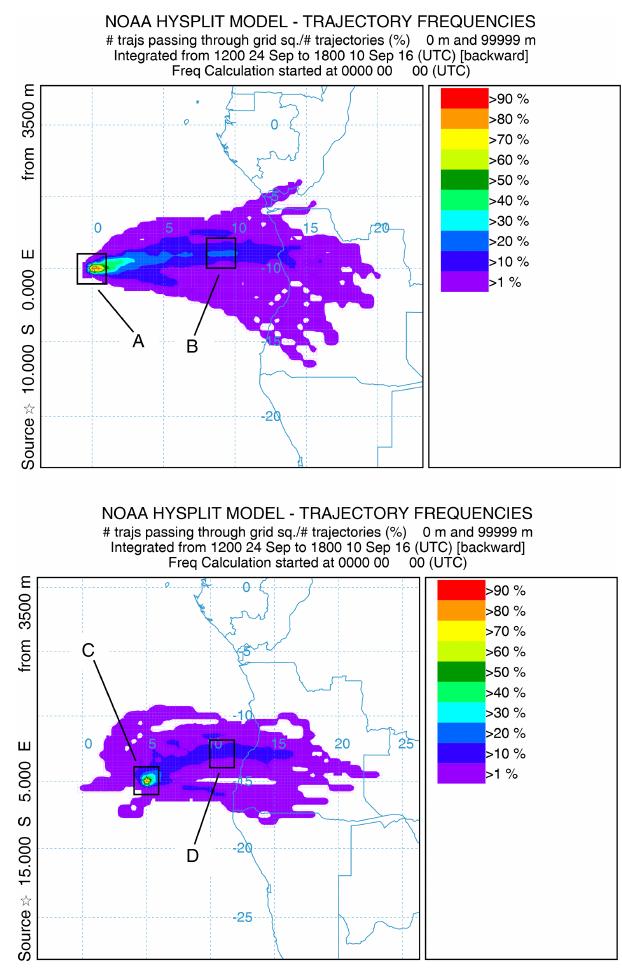
Figure 4. Frequency distribution of 48h backward trajectories of air parcels arriving at 3500m above the centers of grid boxes A and C over the time period of the campaign. Grid boxes B and D are upstream of grid boxes A and C,